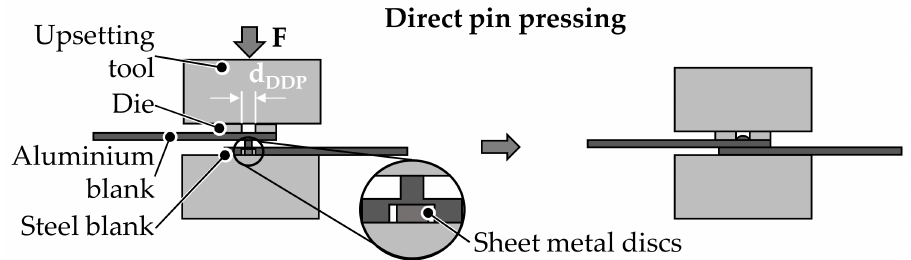
Figure 3. Schematic illustration of direct pin pressing with a